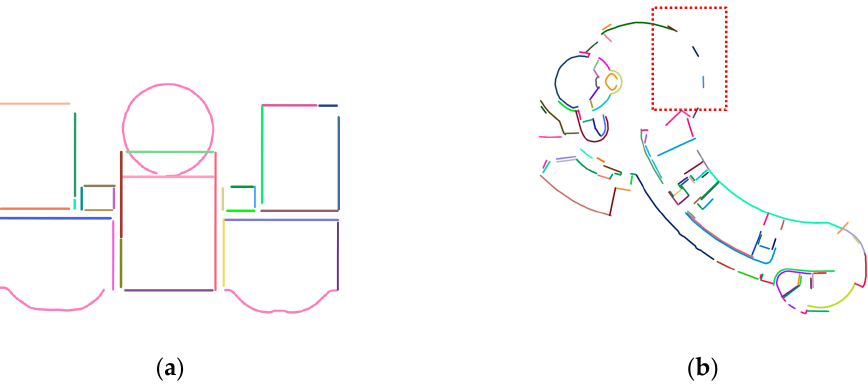
Figure 12. ( a ) Line tracing and regularization results for dataset-1; and ( b ) line tracing and regularization results for dataset-2. Because glass walls exist in dataset-2, the curved wall in the red box was detected as incomplete.